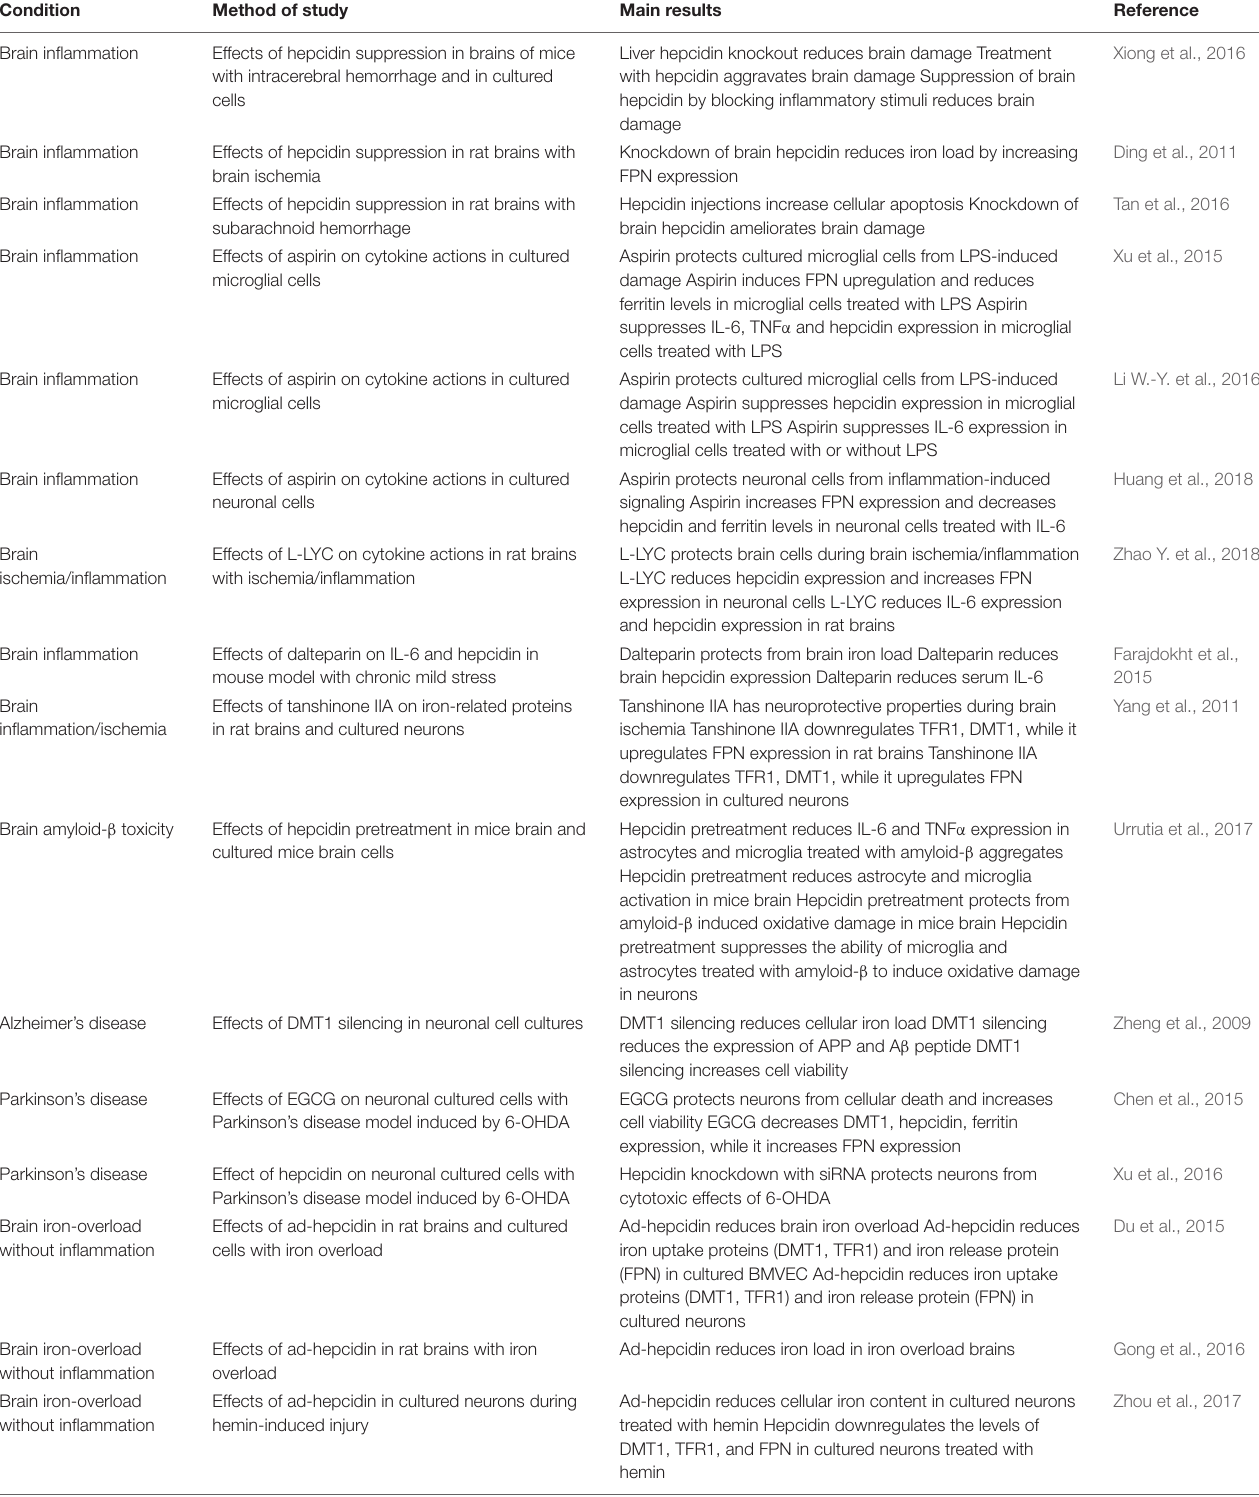
TABLE 1 | Therapeutic potential of the manipulation of hepcidin and its target proteins in neurodegeneration.